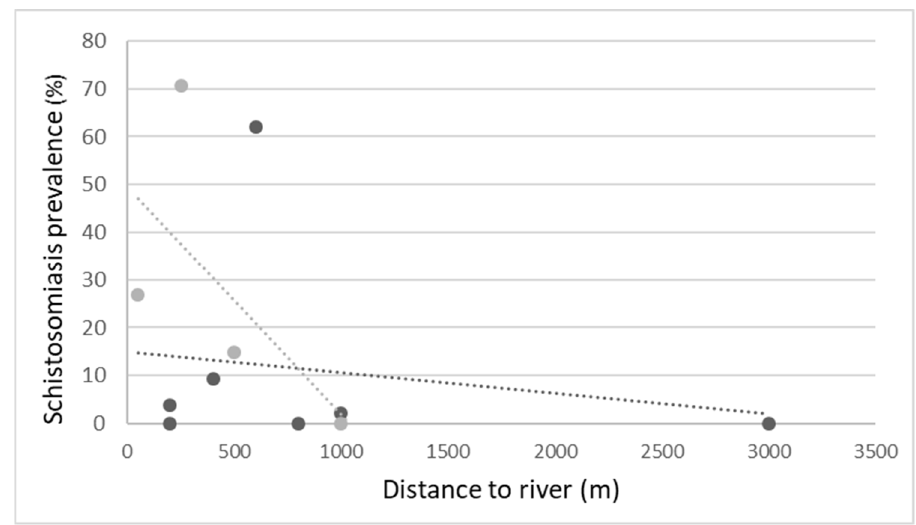
Figure 1. School distance from river and schistosomiasis prevalence, by location. Black dots: urban location; grey dots: semi-urban location.